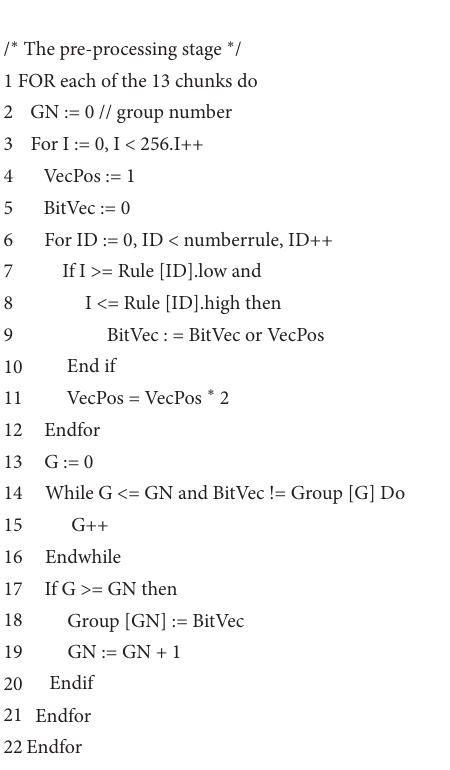
Figure 1: PCIU preprocessing stage